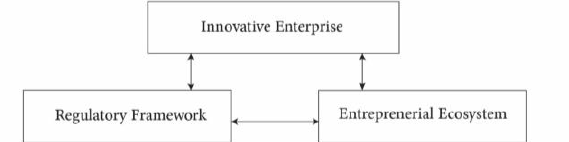
Figure 3 . Smart city strategy toward entrepreneurial ecosystem, illustrated by authors